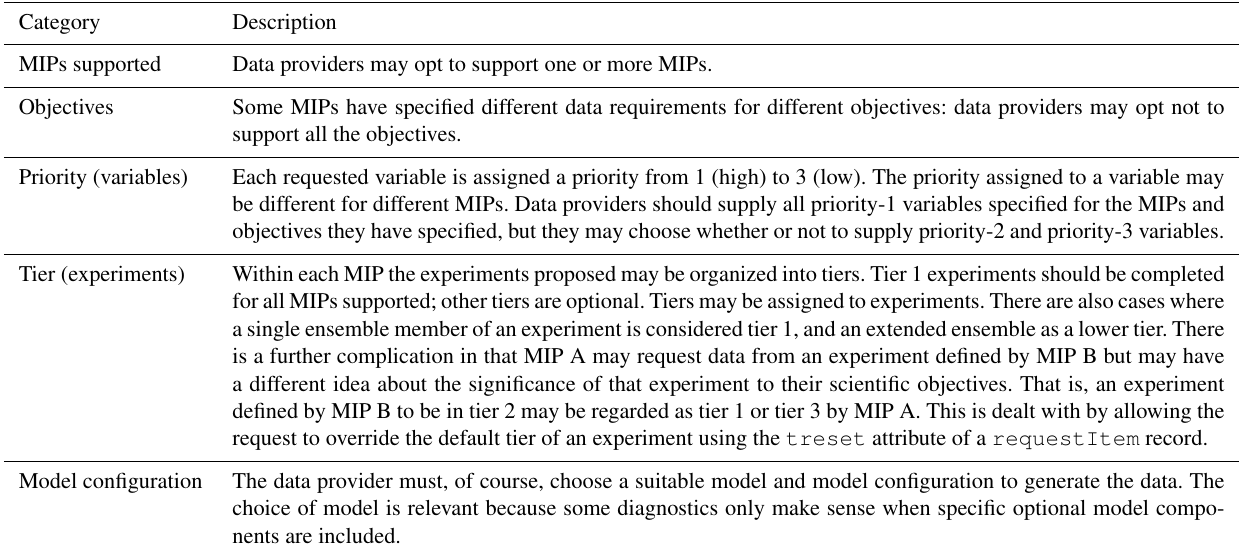
Table 2. Choices confronting data providers within the CMIP6 Data Request (DREQ). Category